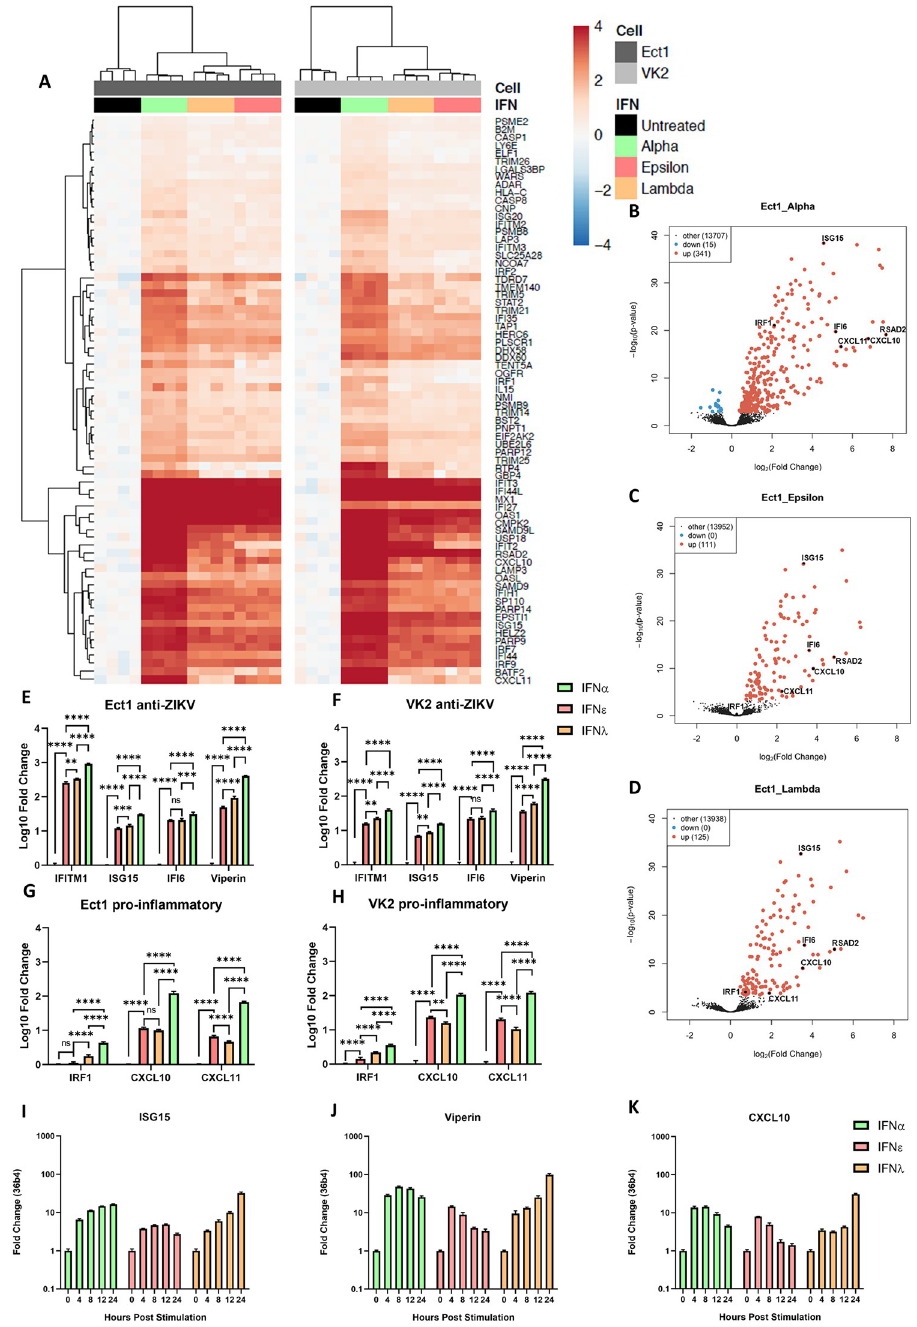
Fig 3. IFN ε displays typical type-I IFN kinetics but induces an antiviral gene signature like IFN λ -3 at early time points in ectocervical and vaginal cells. Ect1 and VK2 cells were treated with IFN ε , IFN α -2a or IFN λ -3 (100 ng/mL) or left untreated (n = 4) for 6hr prior to RNA-seq analysis (NextSeq550 V2.5). Differentially expressed genes were determined with a 1.2-fold cut-off and adjusted p-value < 0.05. A) Heat map showing expression of key ISGs. B, C & D) Volcano plots indicating up or downregulation of genes after IFN α -2a, IFN ε or IFN λ -3 treatment, respectively. E & F) Confirmation of anti-ZIKV ISGs (ISG15, IFI6, IFITM1, Viperin) expression by qRT-PCR. G & H) Confirmation of pro-inflammatory ISGs (IRF1, CXCL10, CXCL11) expression by qRT-PCR. Statistical analyses for E-G were performed separately for each gene by one-way ANOVA. I, J & K) Ect1 cells were treated with IFN ε , IFN α -2a or IFN λ - 3 (100 ng/mL) and RNA was harvested from untreated cells (t = 0) and at the indicated time points post stimulation. qRT-PCR was performed to detect expression of ISG15, Viperin and CXCL10.